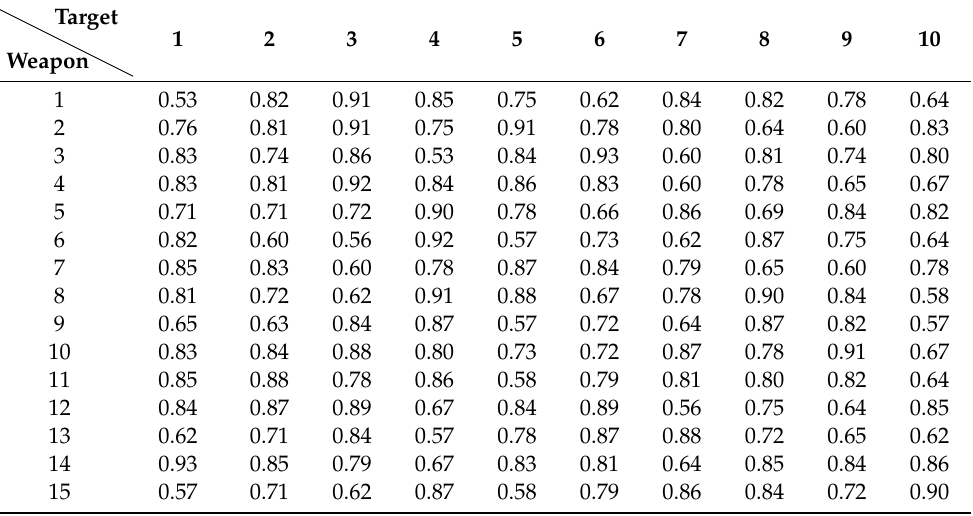
Table 2. Probability of each